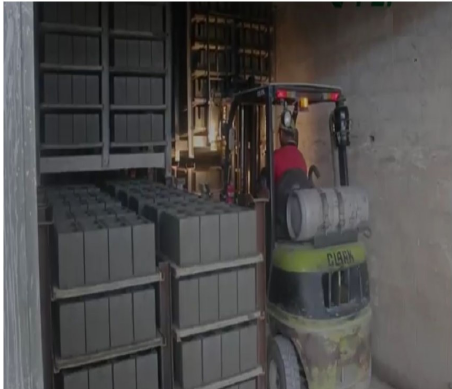
Figure 15. Steam curing chamber in a concrete block industry in the state of São Paulo. Source: Author